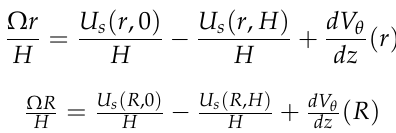
Ω r where is the apparent shear rate, H . γ ( R ) , imposed on the fluid at r = R , i.e., corresponding to the shear stress at the shear rate, Ω edge, τ z θ ( R ) . where is the apparent shear rate, H true shear rate, ( ) R γ  , imposed on the fluid at r = R , i.e., corresponding to the shear stress can obtain the slip velocity versus the shear stress behavior. at the edge,